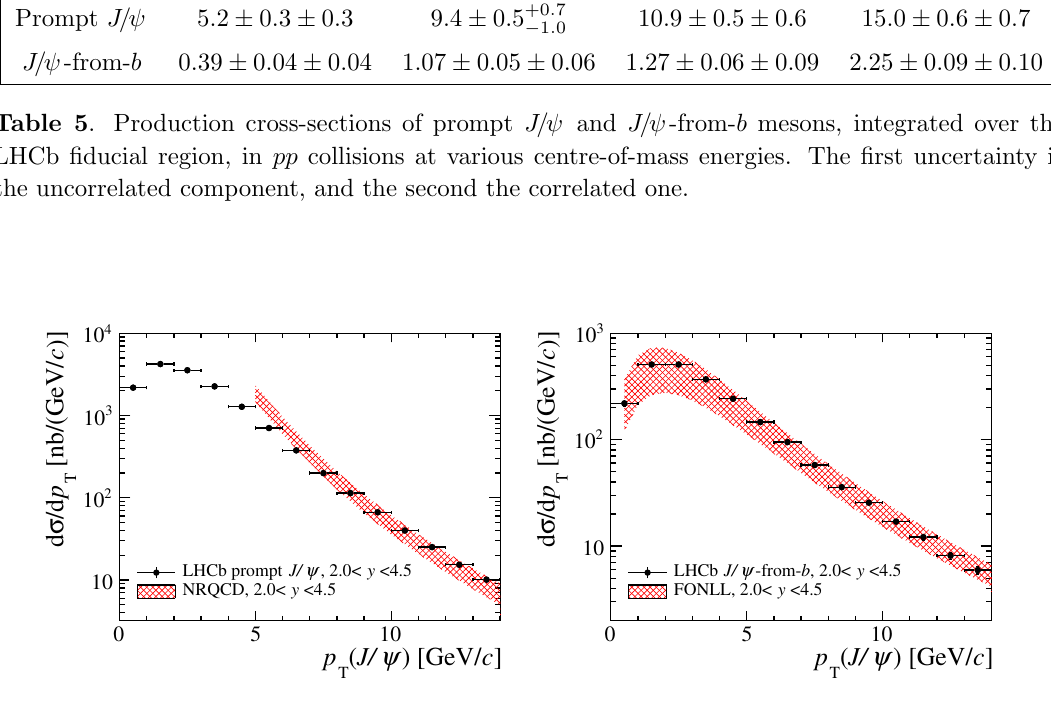
Figure 11 . Di(cid:11)erential cross-sections as a function of p T integrated over y in the range 2 : 0 < y < 4 : 5, (left) compared with the NRQCD calculation for prompt J= and (right) compared with the FONLL calculation for J= -from- b mesons.